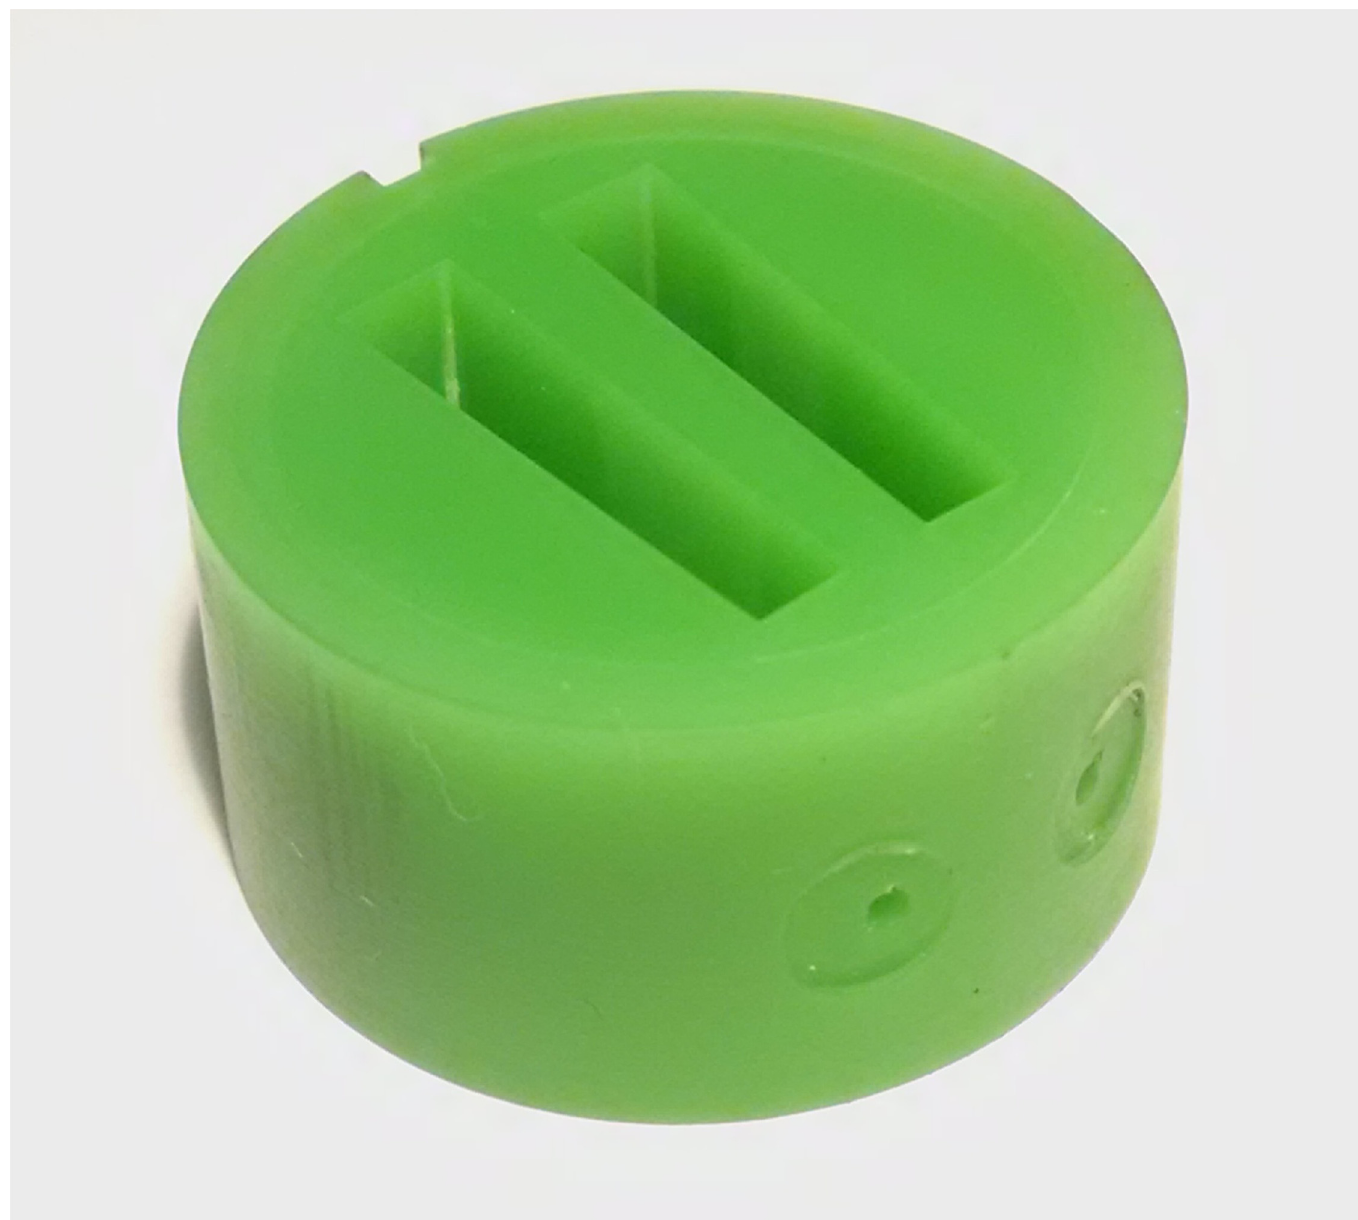
Fig 1. Picture of a 12 mm pathlength centerpiece printed of ABS-like resin MicroFine Green. Sedimentation velocity data of BSA at 50,000 rpm collected with this centerpiece installed into a standard cell assembly without gaskets are shown in Fig